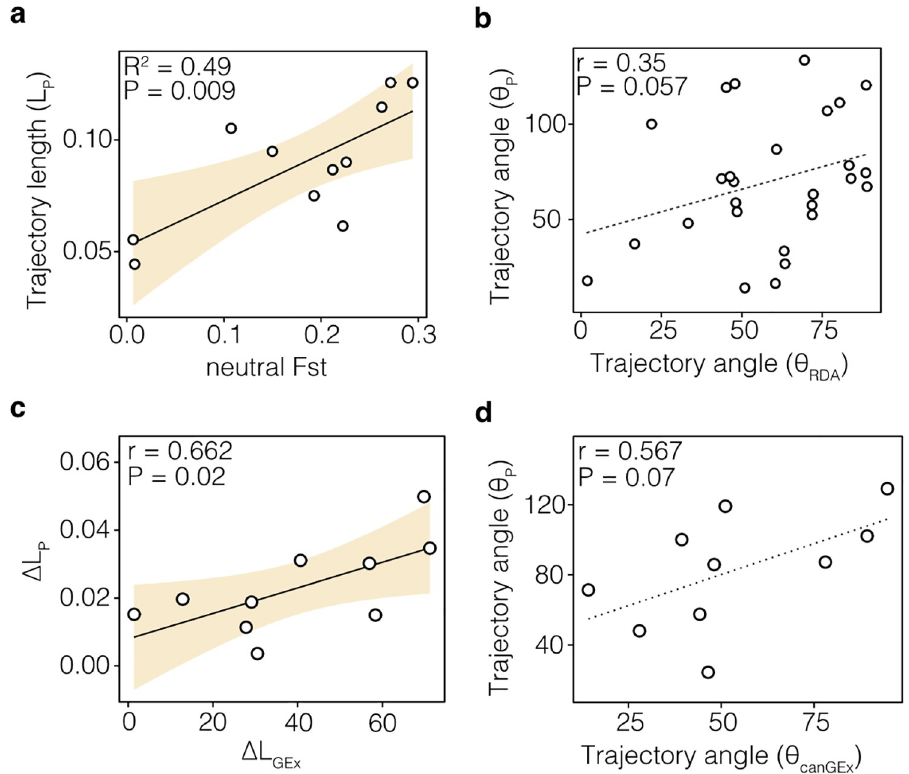
Fig 7. Correlation of gene expression and genetic variation with phenotypic divergence. ( A ) Significant correlation between the degree of neutral genetic differentiation (neutral Fst) and phenotypic divergence (L P ), with the shaded area highlighting the 95 th confidence interval (CI) (N = 11). ( B ) The direction of allele frequency change of ecotype- associated loci ( θ RDA ) showed a weak correlation with the direction of phenotypic change ( θ P ) across ecotype pairs (N = 27). The dotted regression line shows the weak but non-significant correlation. ( C ) Differences in the magnitude of phenotypic divergence ( Δ L P ) are significantly correlated with differences in the magnitude of gene expression divergence ( Δ L GEx ) between sympatric Arctic charr ecotypes (N = 10). ( D ) The direction of expression trajectories of ecotype-associated genes ( θ canGEx ) tends explain the direction of the phenotypic trajectories ( θ P ) (N = 10). Each panel shows the linear model or Mantel test result.